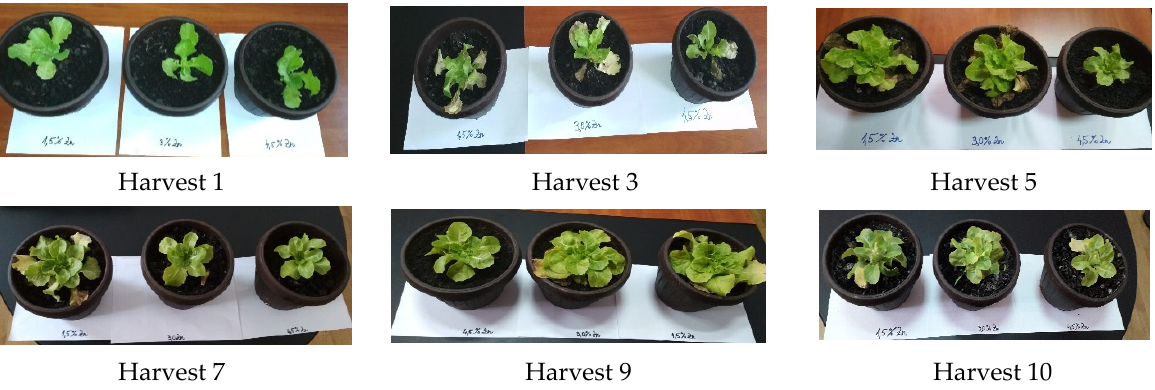
Figure 2. Plants with different contamination concentrations, harvested at different time periods after cultivation.